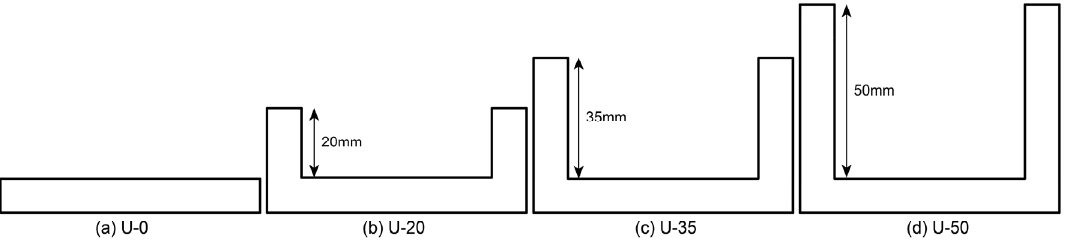
Figure 4. The different height of U-type obstacles.